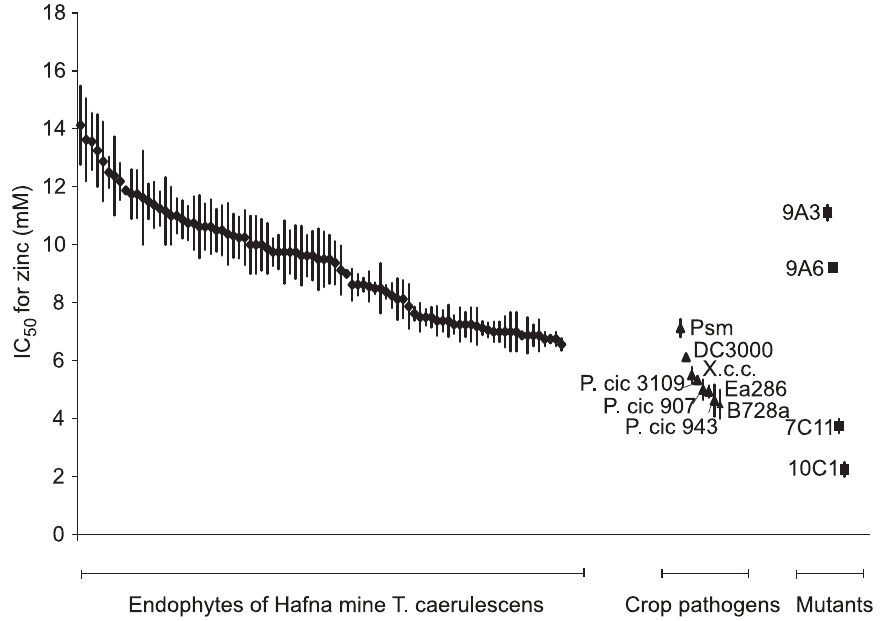
Figure 8. Bacterial endophytes isolated from a natural population of Thlaspicaerulescens exhibit high zinc tolerance. To determine IC 50 values for zinc, 5 m l of bacterial suspension at an OD 600 of 0.2 were inoculated into 200 m l of KB broth supplemented with zinc at 0 to 20 mM. OD 600 was measured after incubation, with continuous shaking, at 28 u C for 48 hours, and IC 50 values were calculated from the resulting dose– response curves. Values are means 6 SE ( n =3). Diamonds = Hafna mine endophytes; triangles = plant pathogenic bacteria isolated from non- metal-accumulating crop plants; squares = mutants of P. syringae pv. maculicola generated in the present work. Abbreviations: DC3000, Pseudomonas syringae pv. tomato DC3000; X.c.c. , Xanthomonas campestris pv. campestris 8004; P. cic 3109, Pseudomonas cichorii NCPPB3109; P. cic 907, P. cichorii NCPPB907; P. cic 943, P. cichorii NCPPB943; Ea286, Erwinia amylovora Ea286; B728a, P. syringae pv. syringae B728a.